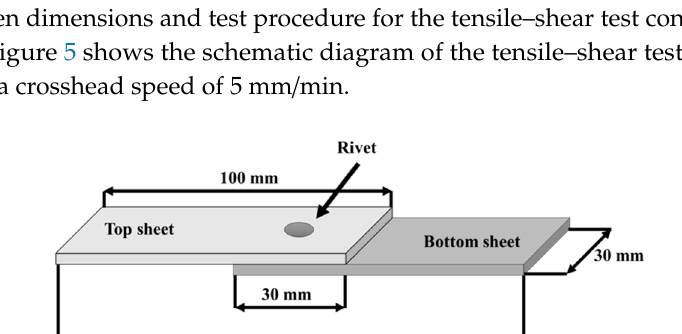
Figure 6. Cross-sectional images for SPR joint of vibration-damping steel (top) and Al5052-H32 (bottom) with respect to SPR die type. ( a ) Type A1 die, ( b ) type A2 die, ( c ) type A3 die, ( d ) type B die,